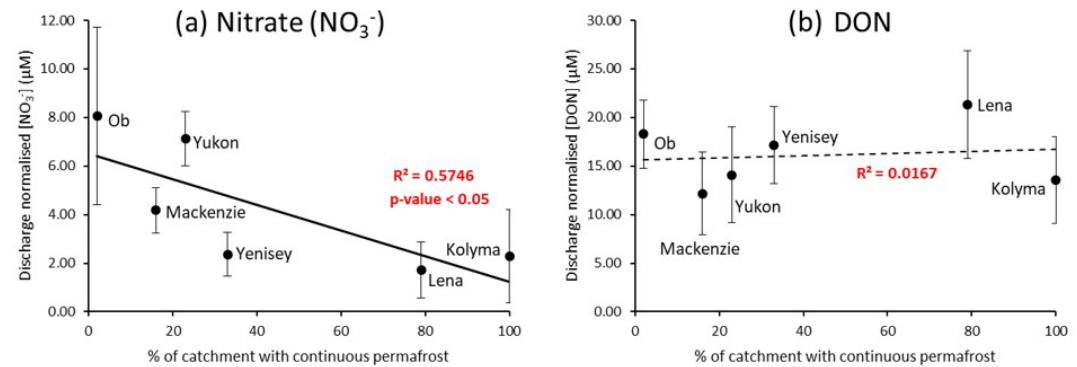
Figure 2. Relationships between the extent of continuous permafrost within each river catchment and (a) nitrate and (b) DON discharge normalized concentrations (µM) for the period 2003–2018. Data are from the ArcticGRO online dataset. Error bars from the discharge normalized standard deviations are quite large due to the large year-to-year variability in nitrate / DON concentrations, however these do not affect the overall trends